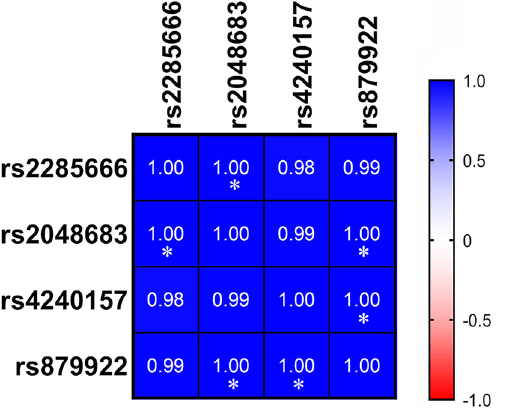
Figure 5. Positive correlation between ACE2 variants. Correlation plot showing the correlation between the different detected SNPs. The heatmap colors reflect rs2285666, rs2048683, rs4240157, and rs879922 are the most significantly correlated. Pearson correlation coefficients with blue for positive correlation and red for negative correlation. * p < 0.05; ** p < 0.01.